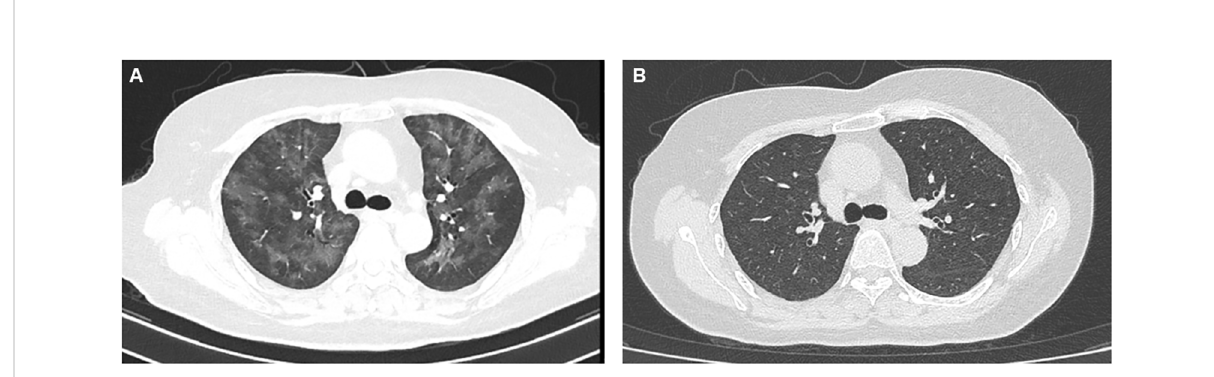
FIGURE 1 The performance of CT scan of the pulmonary infection induced by hormone use (A) and the result of CT image after anti-infection as well as symptomatic treatment (B)